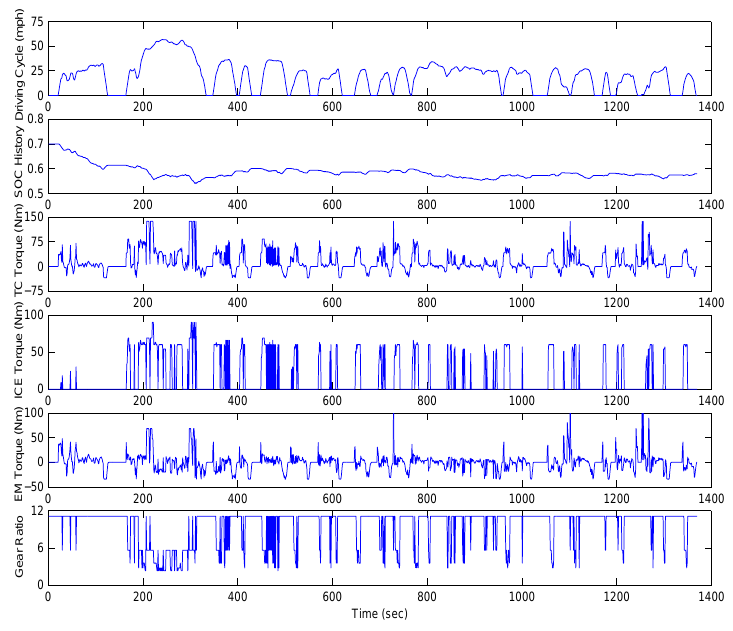
Figure 5. SDP EMS simulation results under UDDS.